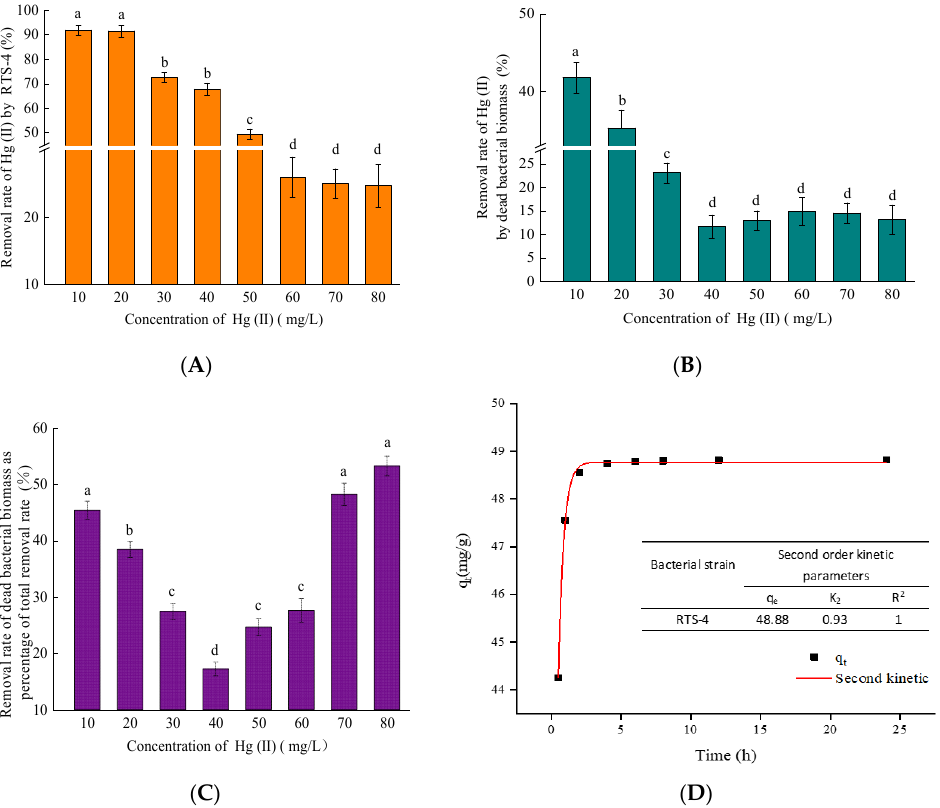
Figure 4. Analysis of Hg(II) adsorption by the dead bacterial biomass (DBB) produced by the RTS-4 bacteria under different concentrations of Hg(II). ( A ) Removal rate of Hg(II) by the RTS-4 bacterial strain under different concentrations of Hg(II) (control group); ( B ) removal rate of Hg(II) by the dead bacterial biomass produced by the RTS-4 bacterial strain under different concentrations of Hg(II); ( C ) dead bacterial biomass removal rate compared to the total removal rate by the RTS-4 bacterial strain; and ( D ) biosorption dynamic curves of RTS-4 bacteria. qt represents the amount of adsorption at t time. “Second kinetic” represents a second-order kinetic curve. The table in Figure D shows the second-order kinetic parameters of RTS-4. qe represents the adsorption capacity at t time (mg/g); and K2 represents the pseudo-second-order adsorption rate constant; R 2 represents the goodness of fit. Bars (means values ± SD) with different letters are significantly different from the three independent experiments at the 0.05 level, according to LSD multiple comparisons.